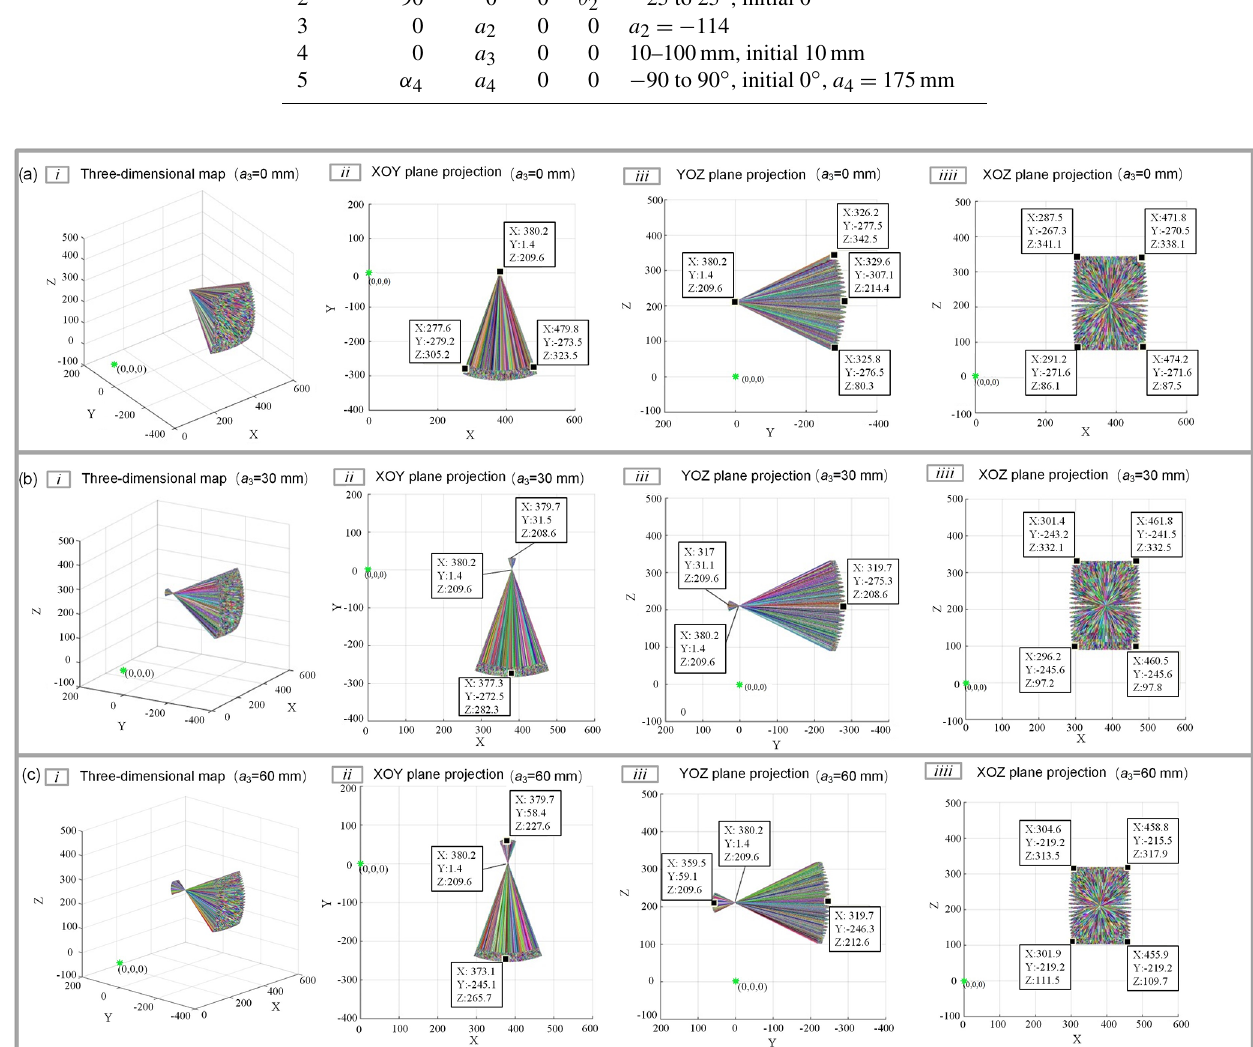
Figure 9. Centering effect of ultrasound probe at 0, 30, and 60mm